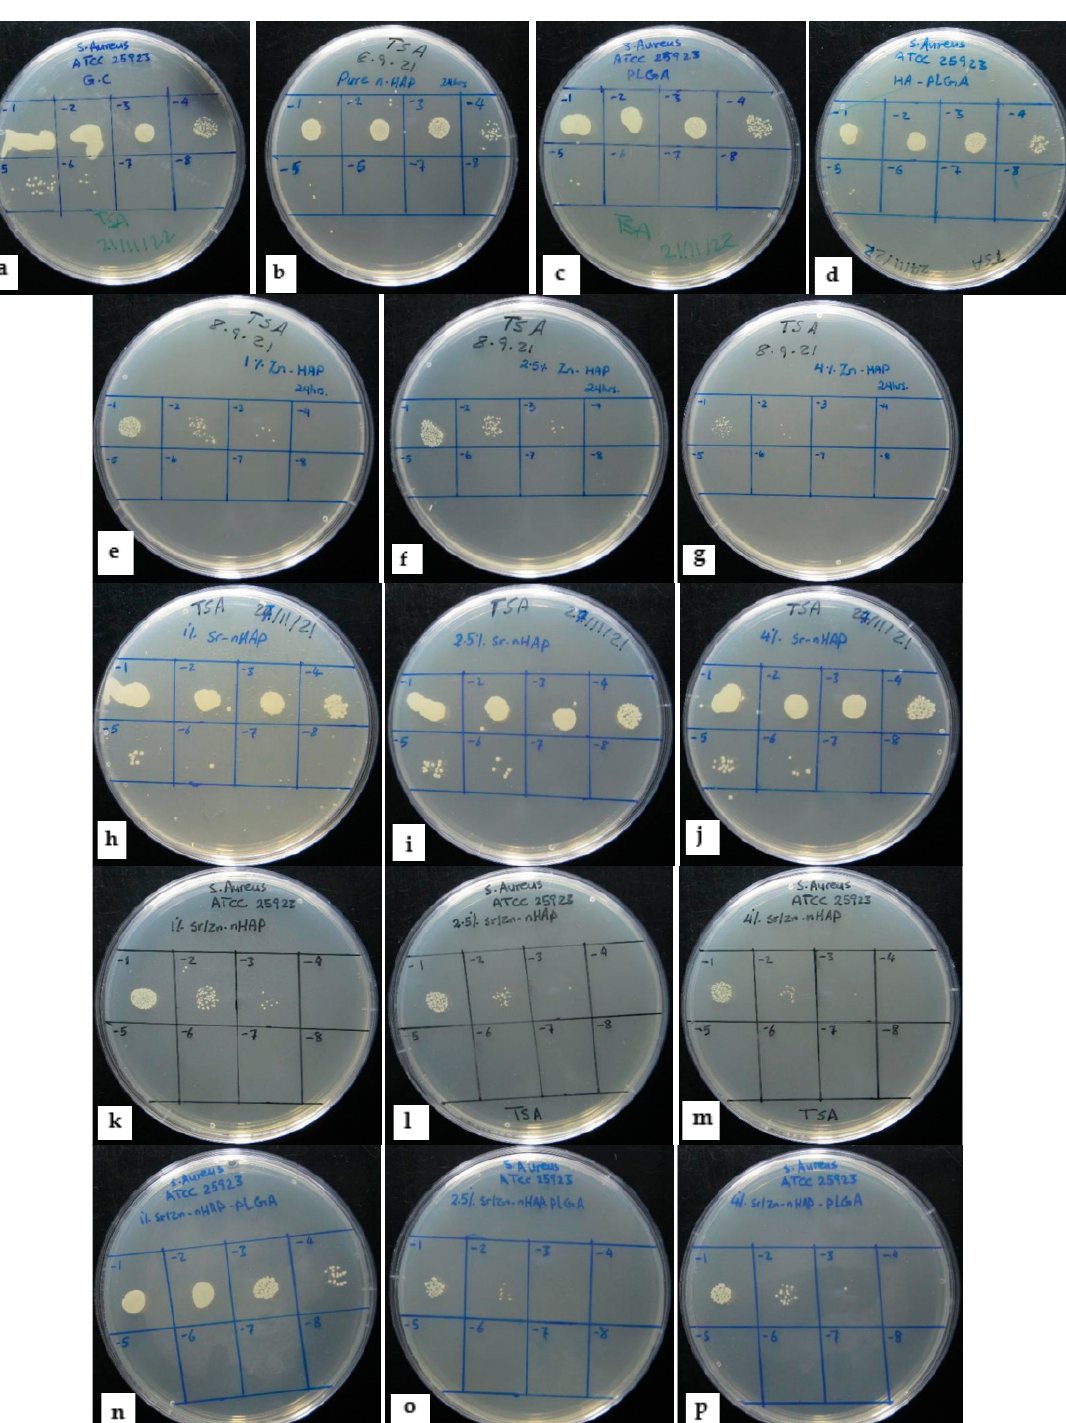
Figure 3. Photographs of bacterial colonies in TSA plates after 24 h of direct contact with different scaffolds. Each square sector represents a serial dilution from 10 − 1 to 10 − 8 , left to right. ( a ) G.C, ( b ) pure nHAp, ( c ) Pure PLGA, ( d ) nHAp-PLGA, ( e ) 1% Zn-nHAp, ( f ) 2.5% Zn-nHAp, ( g ) 4% Zn-nHAp, ( h ) 1% Sr-nHAp, ( i ) 2.5% Sr-nHAp, ( j ) 4% Sr-nHAp, ( k ) 1% Sr/Zn-nHAp, ( l ) 2.5% Sr/Zn-nHAp, ( m ) 4% Sr/Zn-nHAp, ( n ) 1% Sr/Zn-nHAp-PLGA, ( o ) 2.5% Sr/Zn-nHAp-PLGA, ( p ) 4%